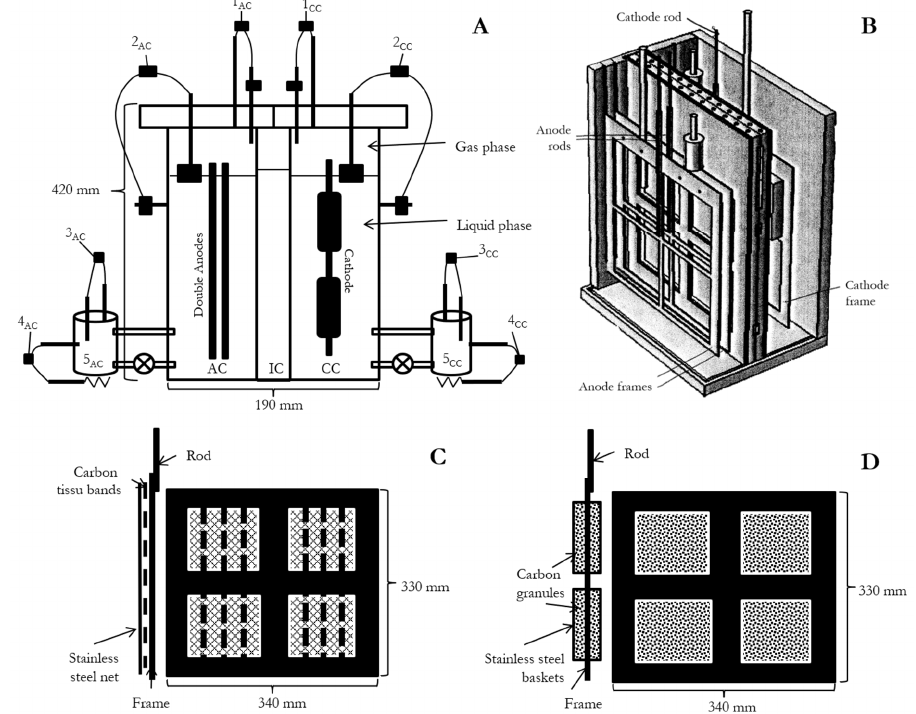
Figure 2. ( A ): A cross-sectional view of the TRL4 reactor showing the AC, IC, CC, automated controlling systems with: 1, gas pressure control, 2, liquid level control, 3, pH control, 4, temperature control; and 5, overflow chambers for AC and CC. ( B ) A proportional 3D model of the reactor’s inside configuration. ( C , D ): schematic diagram of the anode and cathode, respectively, with side and face views. Stainless steel was used for the electrodes’ rod and frame.